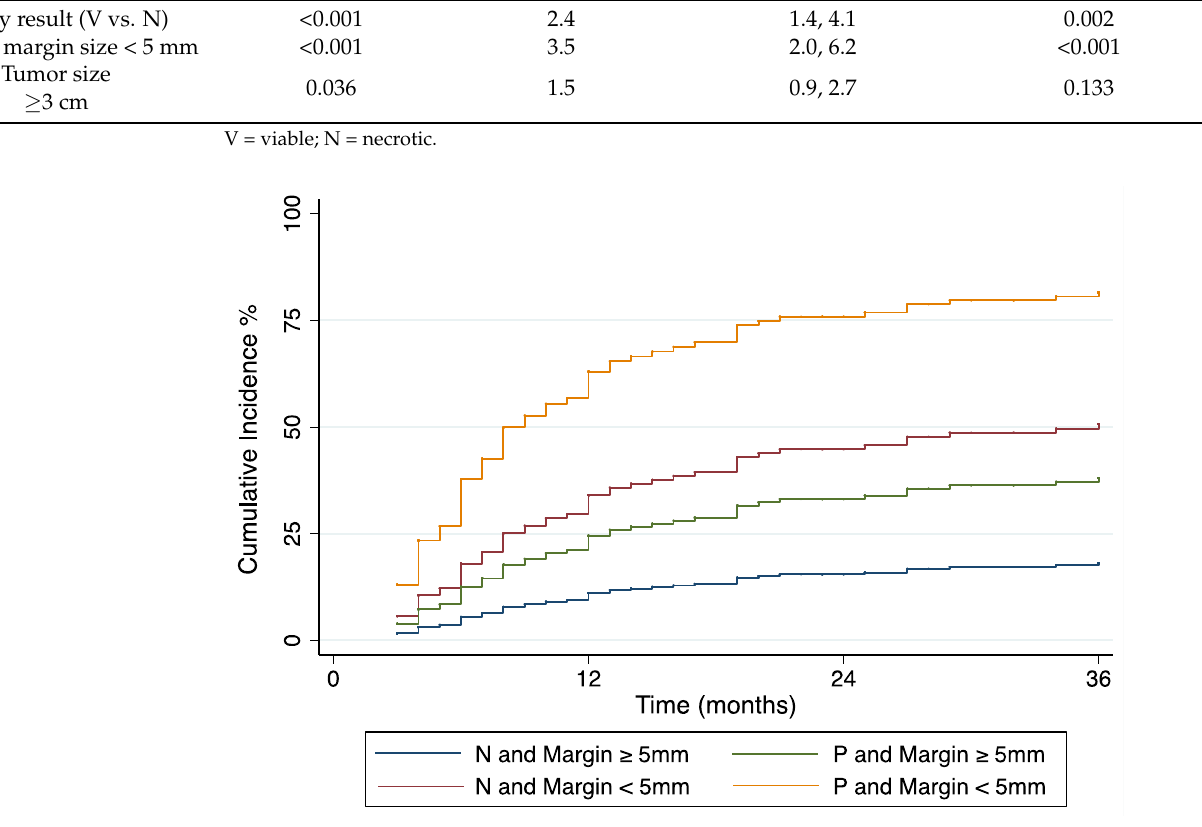
Figure 3. Cumulative incidence of local tumor progression over time stratified by post-ablation bi- biopsy result (N: Negative or P: Positive) and ablation margin opsy result (N: Negative or P: Positive) and ablation margin size.